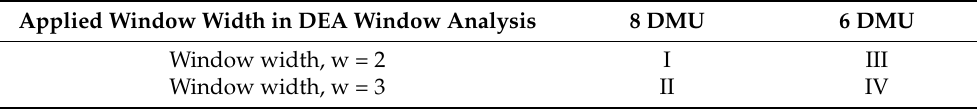
Table 10. Modifications of DEA window analysis model for